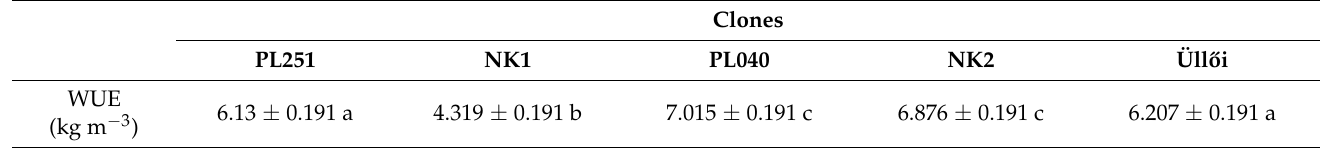
Table 1. Water use efficiency of the black locust clones (29 June 2021).